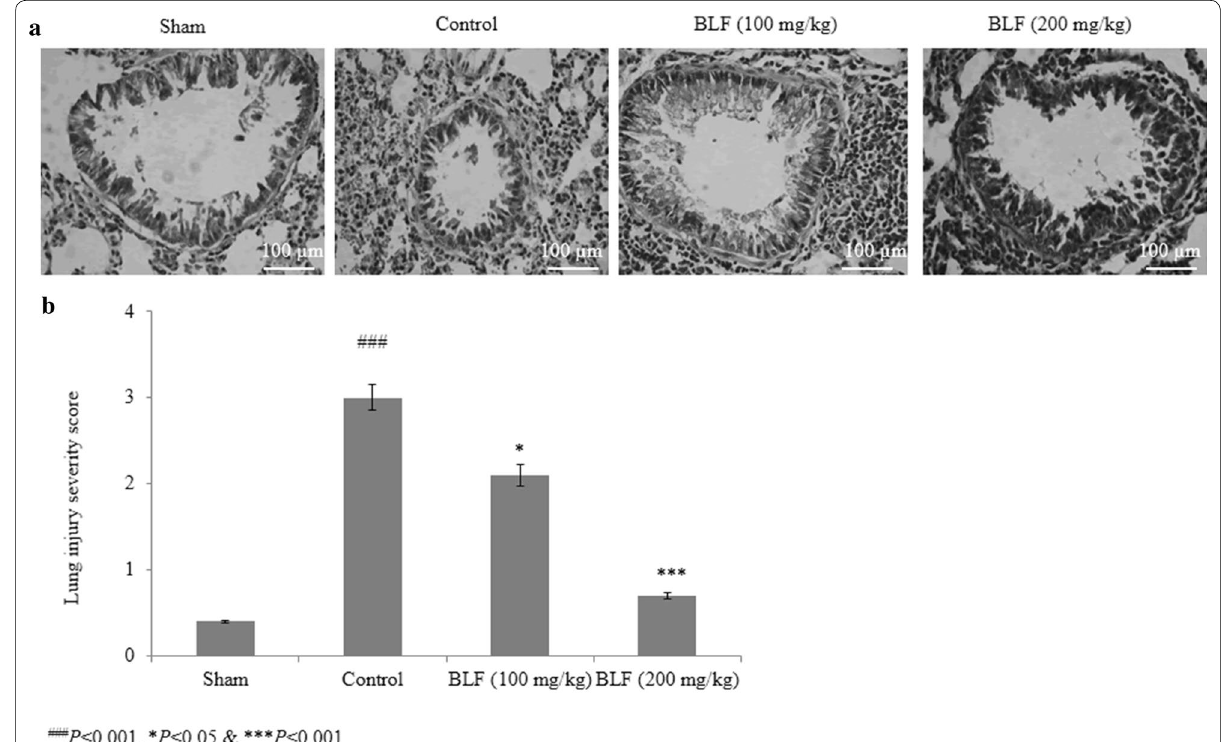
Fig. 8 BLF restores intestinal microvilli damage to within the normal range and reduced inflammatory cell invasion in ALI-induced male albino rats. Rats were given BLF for 30 consecutive days through oral gavage. a Represents the histopathological images of lung tissues and b represents the lung injury severity score. ### P < 0.001 compared to the sham group; * P < 0.05 and *** P < 0.001 compared to control rats. Scale bar is 100